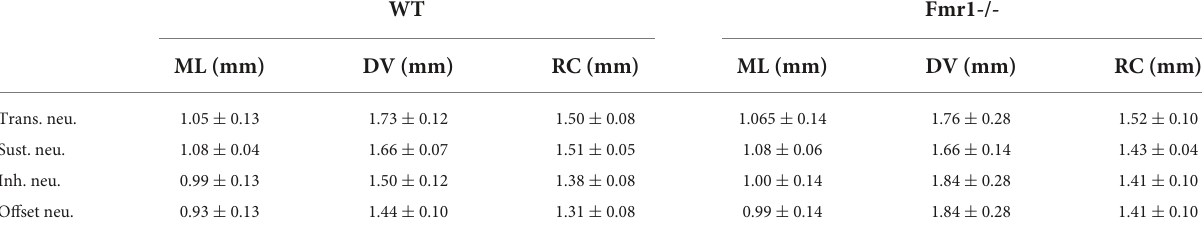
TABLE 1 Mean values ( ± SEM) of the stereotactic coordinates of the four classes of neurons (4 lines for Transient, Sustained, Inhibited, and Offset) in the two genotypes (WT left, Fmr1 -/- right) as shown in Supplementary Figure 1 . WT Fmr1-/- ML (mm) DV (mm) RC (mm) ML (mm) DV (mm) RC (mm) Trans. neu. 1.05 ± 0.13 1.73 ± 0.12 1.50 ± 0.08 1.065 ± 0.14 1.76 ± 0.28 1.52 ±